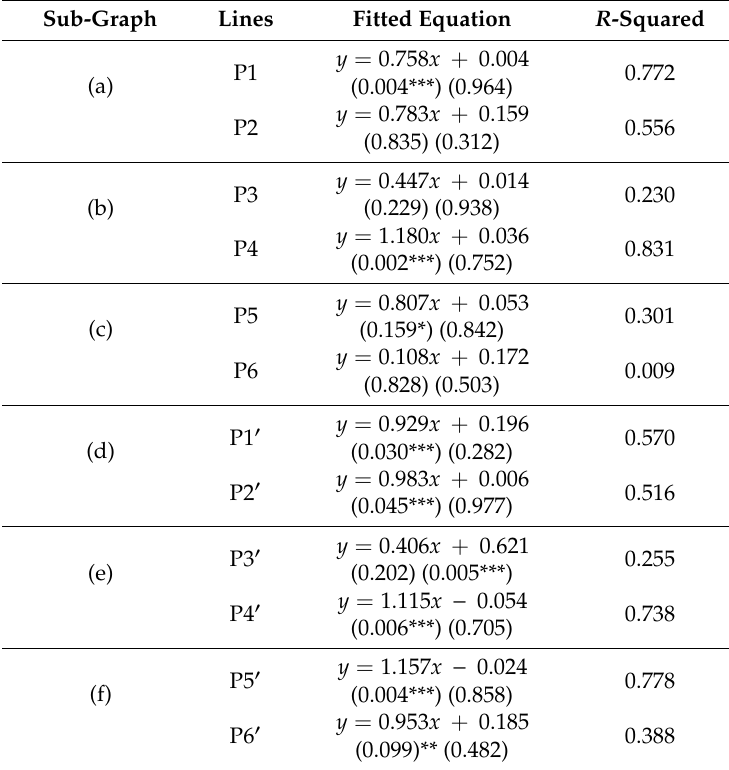
Table A3. Fitted equations and parameters for the curves in Figure 7.